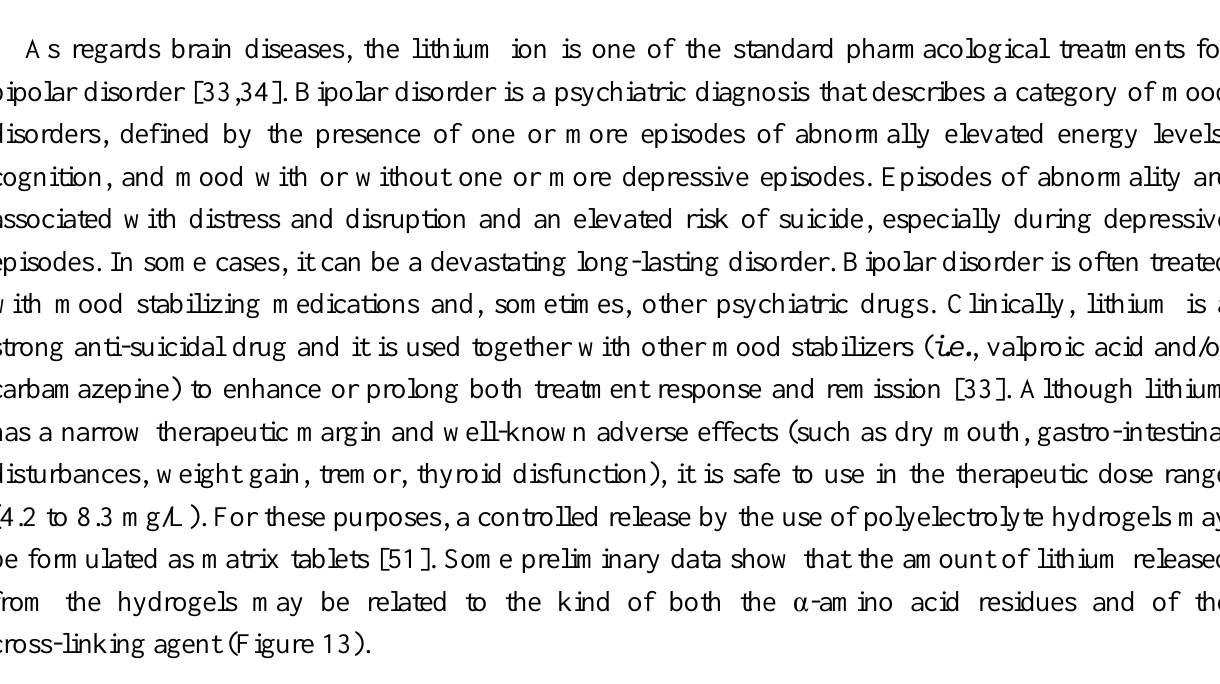
Figure 13. Release pattern of lithium(I) ion from the hydrogels NIP-PHE-PEG258 (1); NIP-AVa-PEG575 (2); AVa-5 (3); and NIP-AVa-PEG258 (4) in water at 25